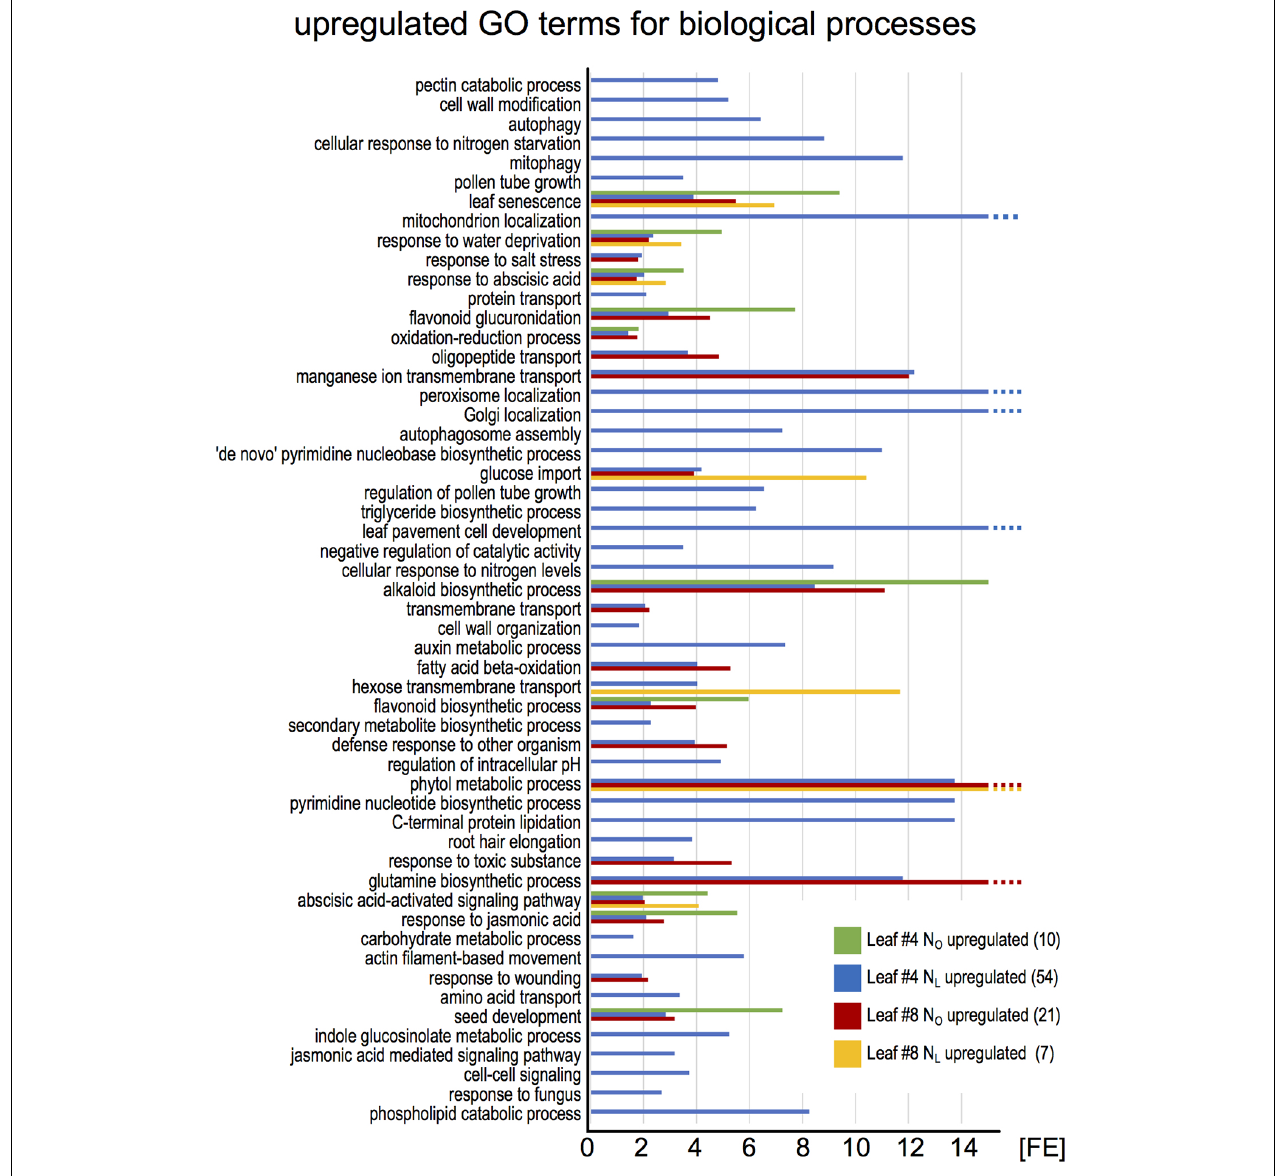
FIGURE 4 | Enriched Gene Ontology terms among upregulated leaf #4 genes. The upregulated genes in all samples (red pictograms in Figure 2 ) were analyzed for enriched Gene Ontology terms using the DAVID Bioinformatics Resources 6.8. The blue bars represent all significantly enriched GO_BP_DIRECT terms in N L leaves #4 ( P < 0.05). Those terms that were also enriched in other samples are shown as green, red, and yellow bars. The lack of a bar indicates that the fraction of upregulated genes in a GO term is not significantly higher than the overall fraction of upregulated genes. The numbers in brackets denote the count of enriched GO